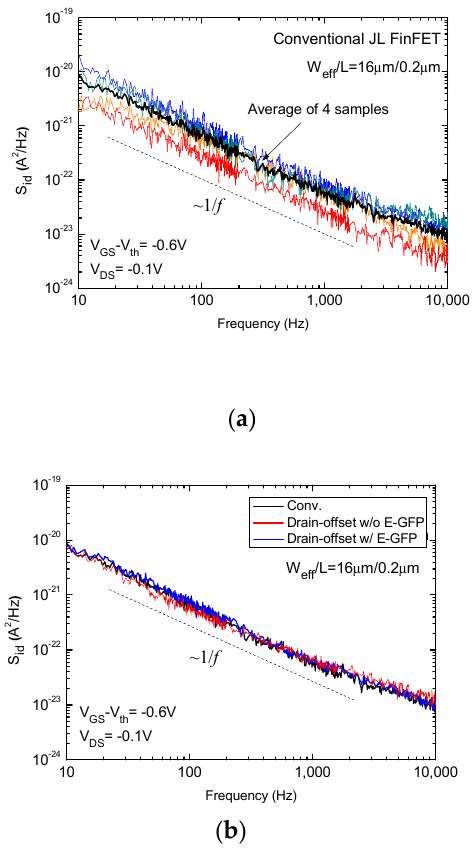
Figure 6. ( a ) Drain current noise spectral density of four samples of conventional JL FinTFT with V DS = − 0.1 V and V GS − V th = − 0.6 V. The average shows a typical 1/ f trend. ( b ) Average value of S Id of various JL